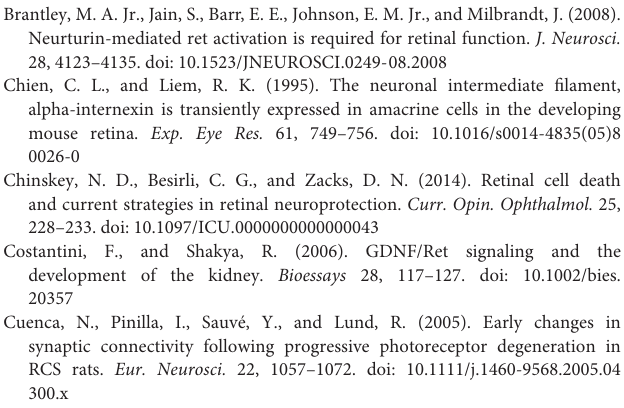
Supplementary Figure 1 | Calbindin staining of horizontal cells in C-Ret lx / lx and Chx10-Cre;C-Ret lx / lx retinas. Immunostaining against calbindin (green), a specific marker for horizontal cells, followed by counterstaining with Hoechst dye to indicate cell nuclei (blue) is shown. Compared to those of C-Ret lx / lx mice (A–D) , confocal microscopic images of horizontal cells at 2 month (E) , 4 months (F) , 12 months (G) , and 24 months (H) of Chx10-Cre;C-Ret lx / lx mice displayed a progressed decrease in calbindin-positive immunoreactivity with an increase in age. ONL, outer nuclear layer; OPL, outer plexiform layer; INL, inner nuclear layer; IPL, inner plexiform layer; GCL, ganglion cell layer. Scale bar, 25 µ m. Supplementary Figure 2 | Mislocalization of photoreceptor synaptic terminals observed in Chx10-Cre;C-Ret lx / lx mice. Retinal sections of animals aged 2, 4, 12, and 24 months were immunostained with an anti-PKC- α antibody (green) and an anti-PSD95 antibody (red), to label rod bipolar cells and the synapses of photoreceptors, respectively, followed by counterstaining with Hoechst dye, to indicate cell nuclei (blue) (A–H) . The processes of rod bipolar cells formed synapses with photoreceptors in the OPL of C-Ret lx / lx mice at all ages (A–D) and Chx10-Cre;C-Ret lx / lx mice at the ages of 2 and 4 months (E–F) . However, extended rod bipolar cell dendrites and ectopic photoreceptor terminals (arrows) in the ONL were observed in 12- and 24-month-old Chx10-Cre;C-Ret lx / lx mice (G,H) . ONL, outer nuclear layer; OPL, outer plexiform layer; INL, inner nuclear layer. Scale bar, 10 µ